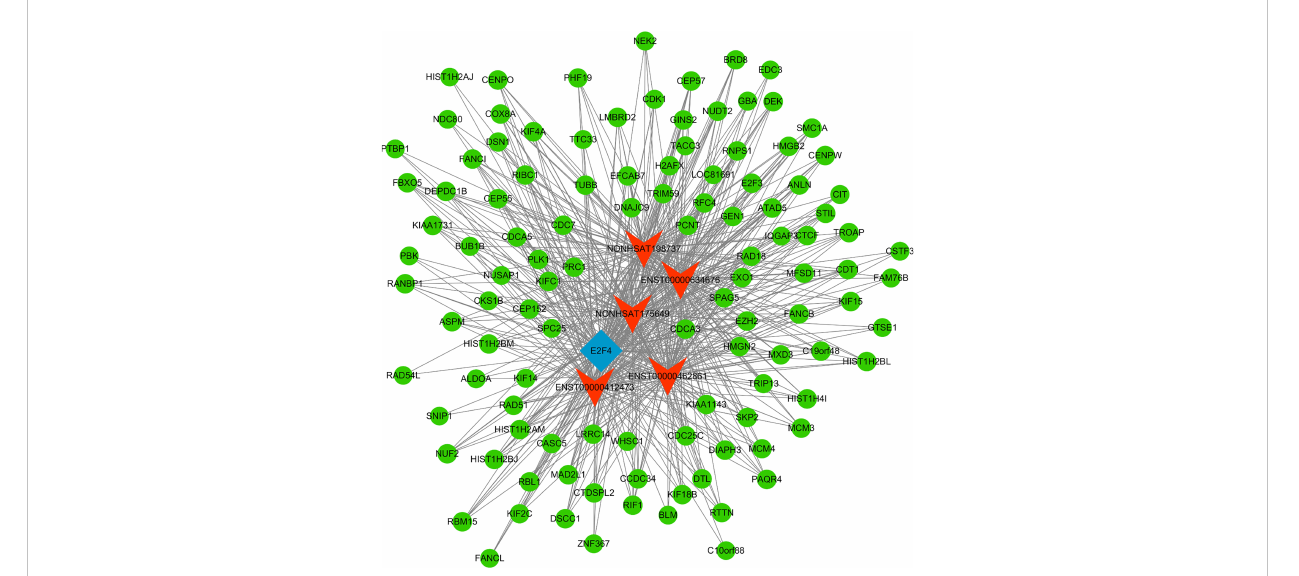
FIGURE 5 TF-lncRNA-mRNA network analysis. mRNAs, lncRNAs, and TFs are respectively represented with green, red, and blue nodes.